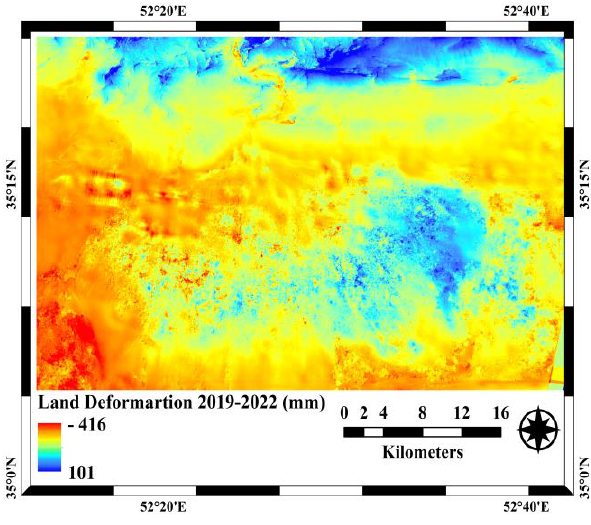
Figure 3. The spatial distribution and critical zone of Cumulative displacement detected by DInSAR